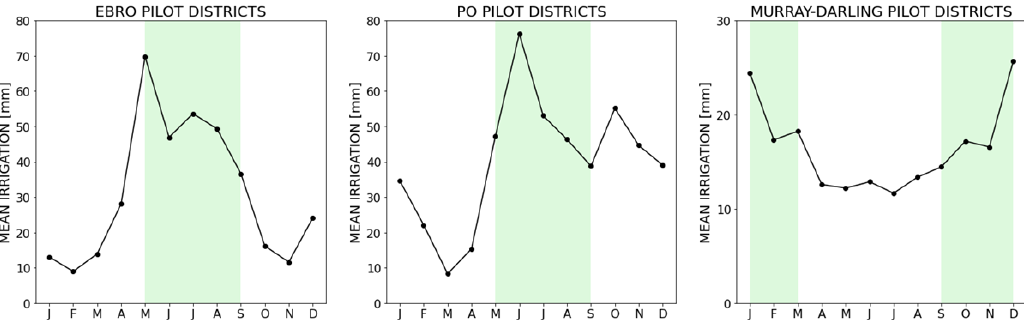
Figure 10. Mean irrigation amounts retrieved per each month of the year over the pilot irrigation districts of the Ebro basin, the Po valley, and the Murray–Darling basin. Note the different y -axis range for the plot referring to the Murray–Darling case